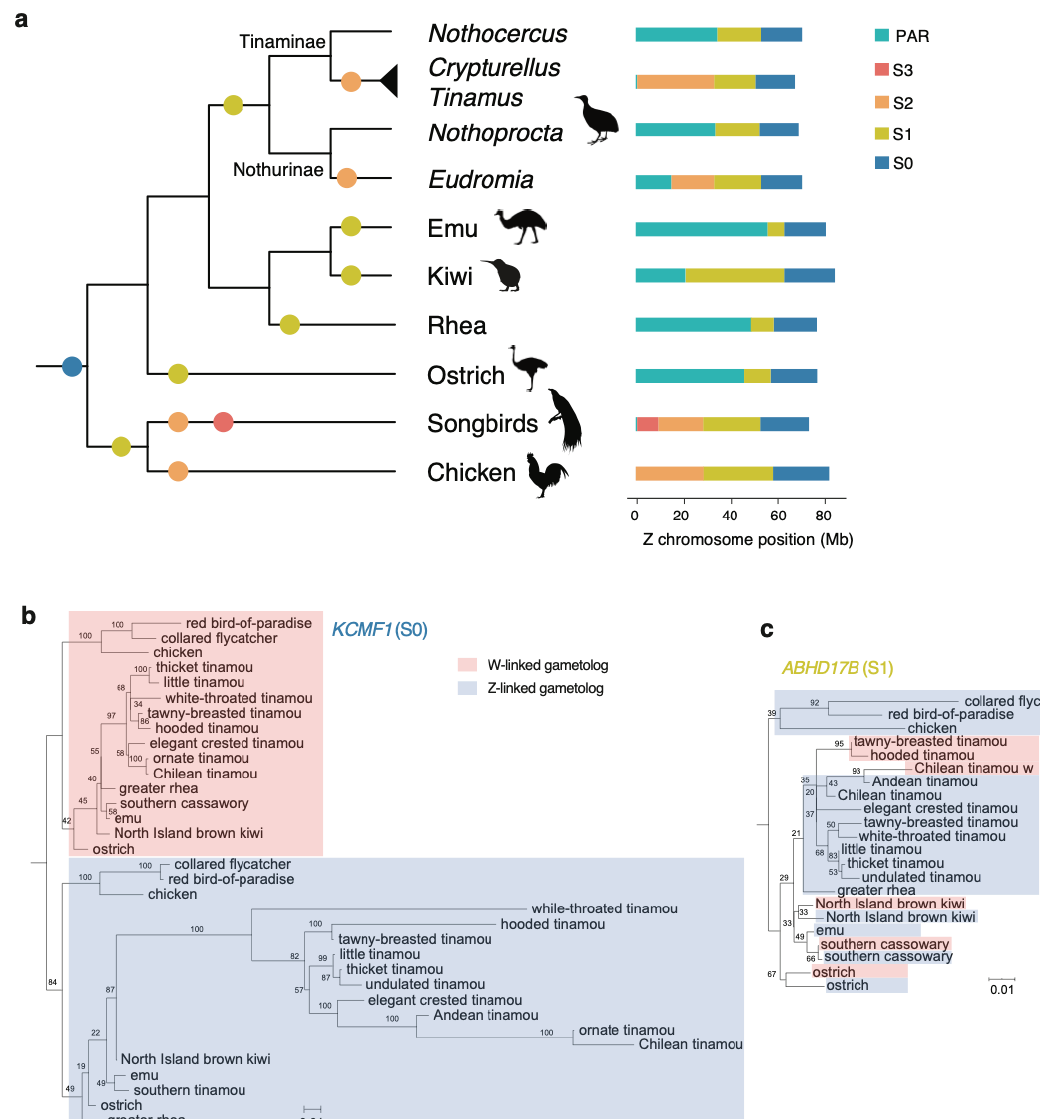
Figure 2. Independent evolutionary strata of sex chromosomes in Palaeognathae. ( a ) The differentiated region of sex chromosomes was divided into evolutionary strata according to the divergence level between the Z and W chromosomes. The colored dots along the branches of the phylogeny indicate the origins of evolutionary strata. The gametolog tree of KCMF1 in ( b ) supports a single origin of S0 in birds, and the gametolog tree of ABHD17B in ( c ) supports multiple independent origins of S1 in Palaeognathae. The numbers at the phylogenetic nodes indicate the bootstrapping values.